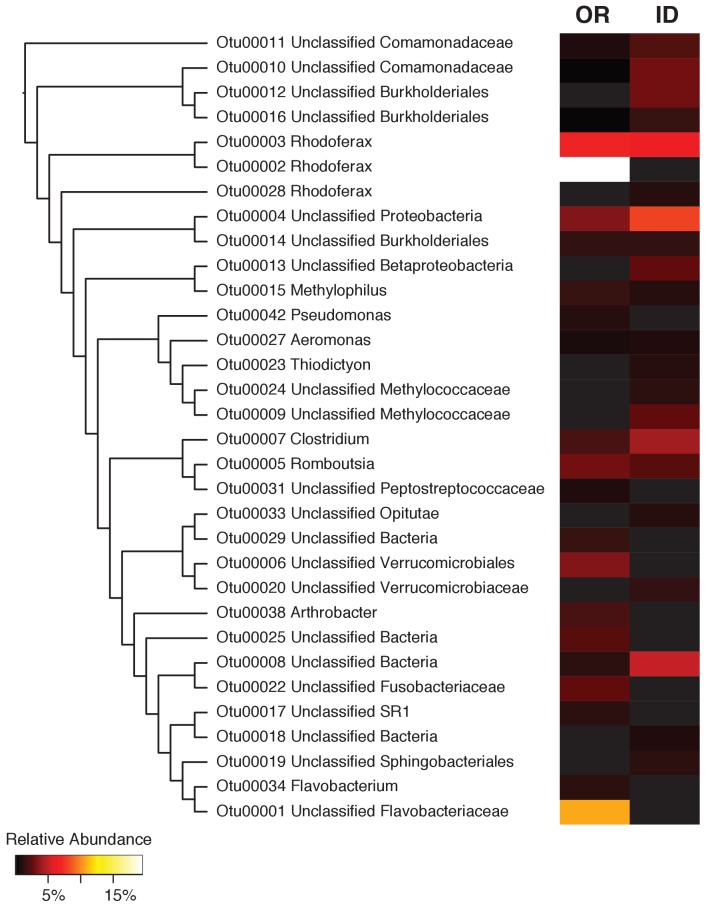
The top 20 most abundant OTUs in the newt microbiome.A clearcut neighbor-joining phylogenetic tree of the top 20 most relatively abundant OTUs with a heatmap displaying the mean relative abundance of each OTU in Oregon and Idaho newts. 12 of these OTUs are unique to one population, while 8 OTUs are shared between both populations.